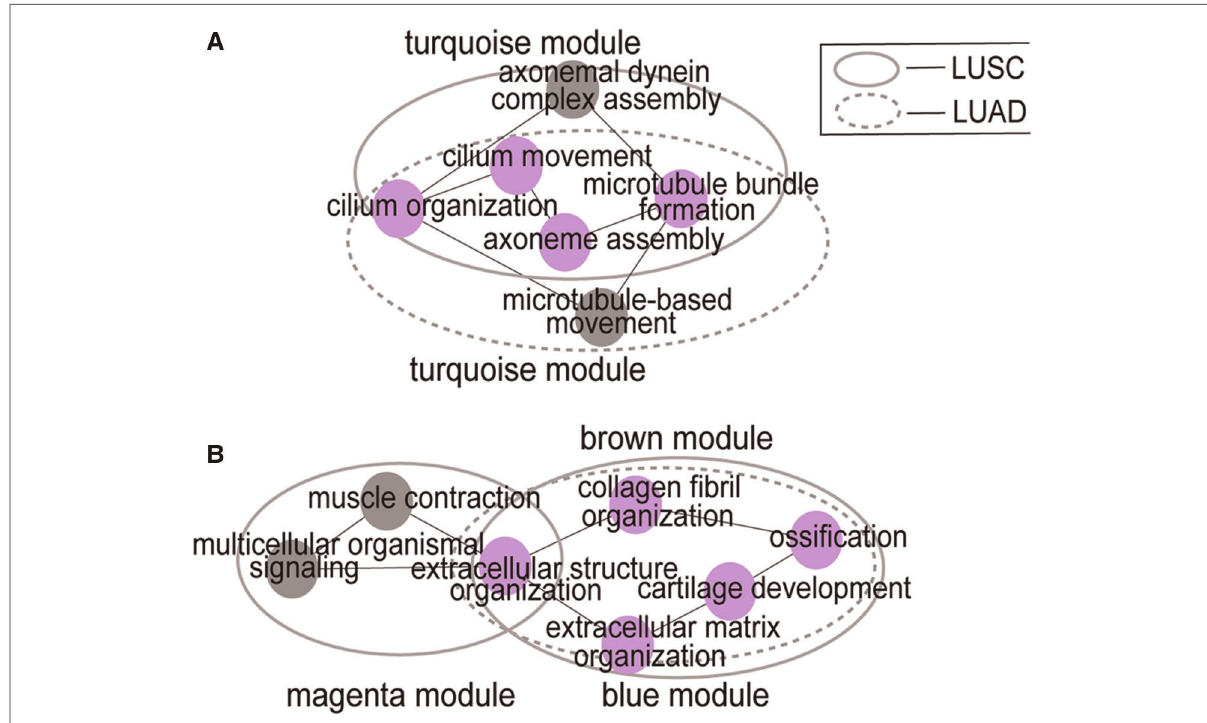
FIGURE 3 Module function similarity. ( A ) shows the functional overlap between LUSC module “ turquoise ” and LUAD module “ turquoise ” ; ( B ) shows the functional overlap between LUSC module “ brown ” and LUAD module “ blue ” , the LUSC module “ magenta ” and the LUAD module “ blue ” . Big circles represent modules and small colored circles represent GO terms. The purple circles represent the inter-network